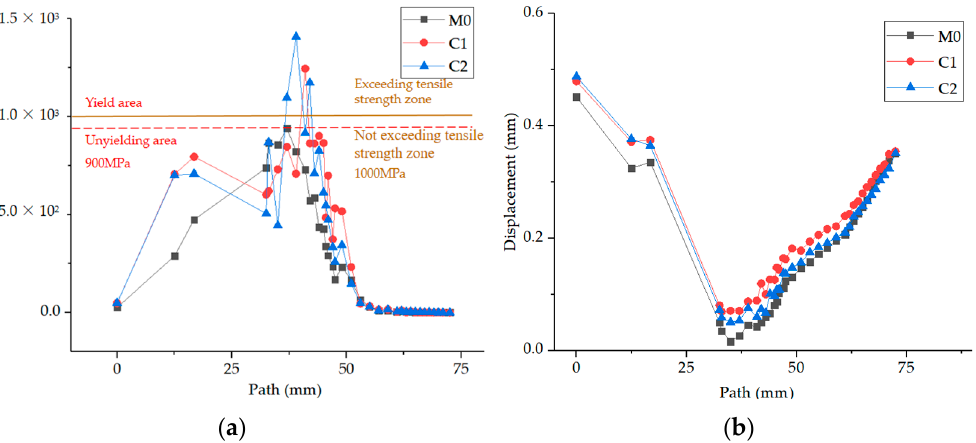
Figure 15. Distribution of stress S and displacement U along the path of thread tooth deformed bolt: ( a ) Stress distribution diagram of C1 and C2 along the path under seismic load; ( b ) Displacement distribution diagram of C1 and C2 along the path under seismic load.